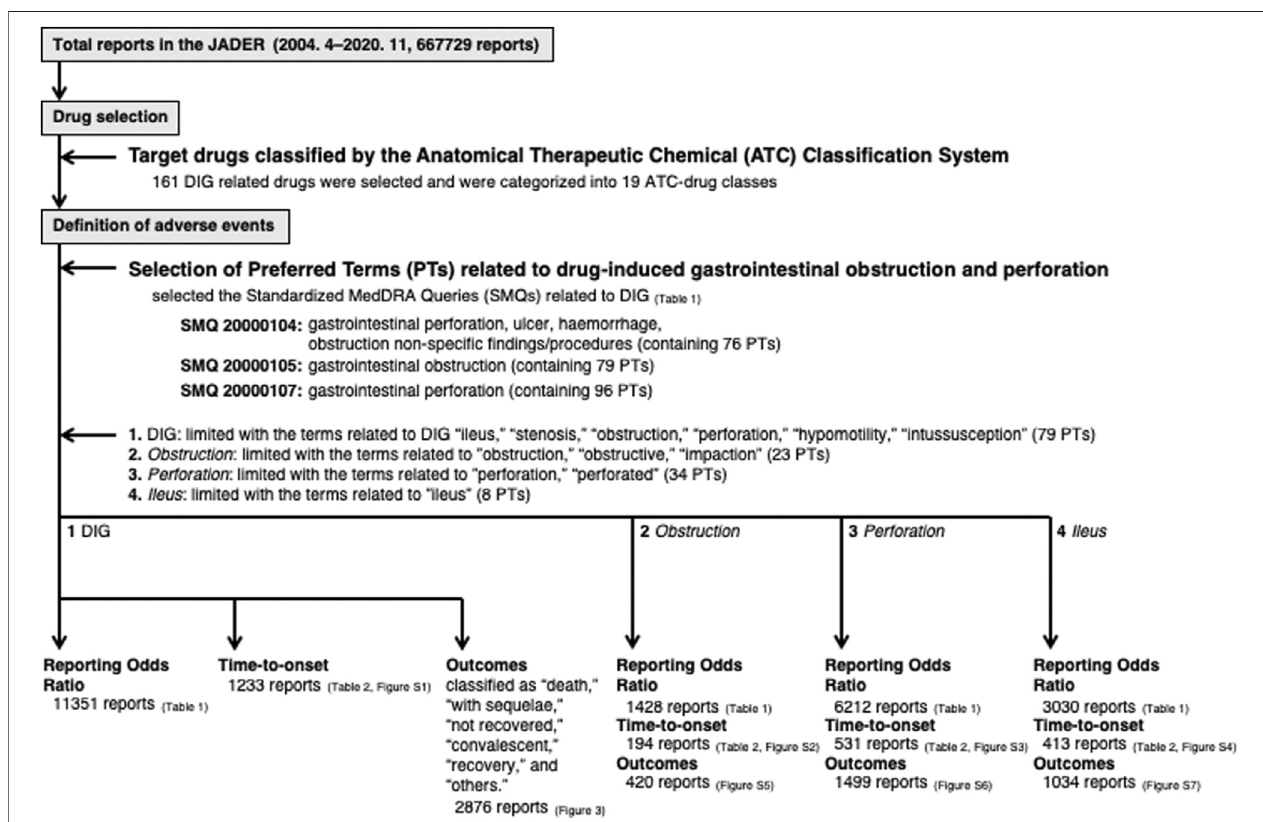
FIGURE 1 | Flowchart of data